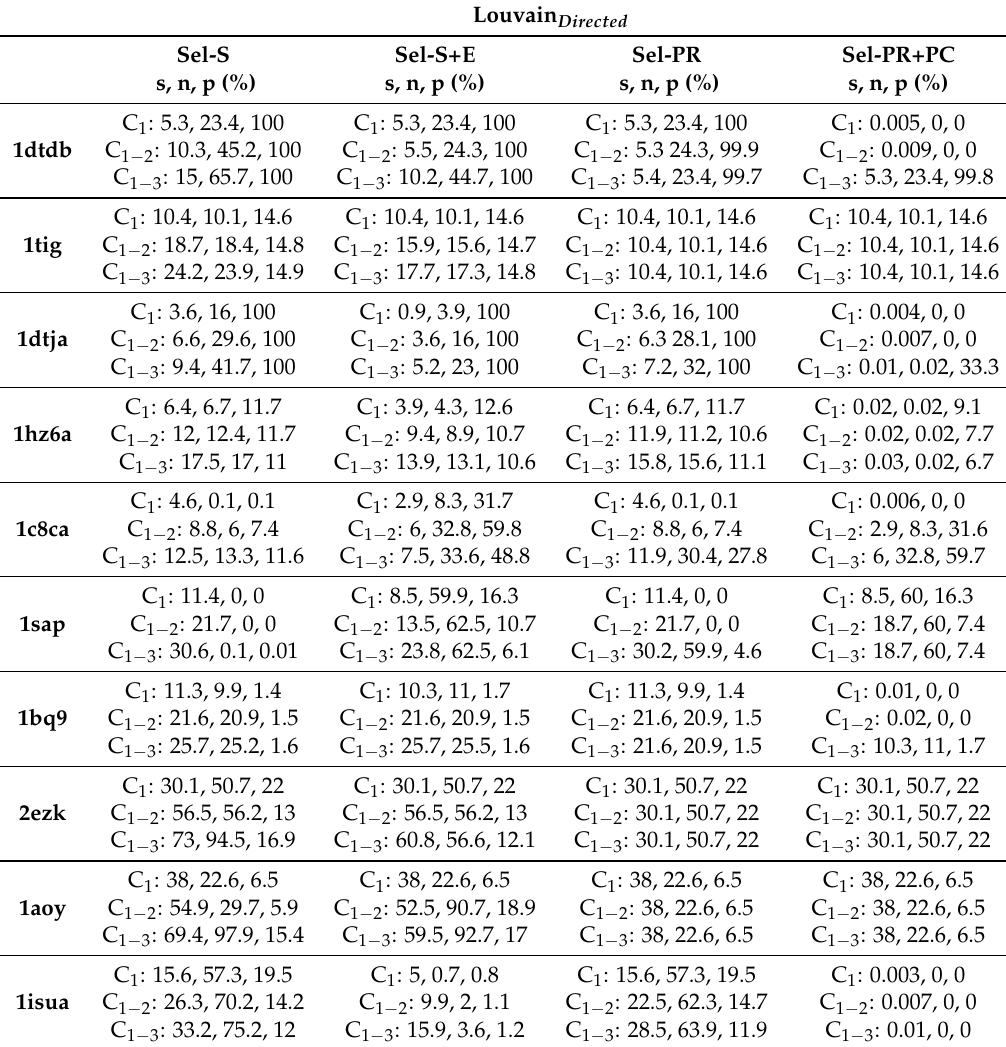
Table 2. The s , n , p of the sets of communities selected by different selection strategies over communities identified by the Louvain algorithm on decoy datasets embedded as directed ngraphs. We refer to this setting as Louvain Directed . Recall that s stands for size (number of decoys), and n and p are the two performance metrics described above (and in more detail in Section